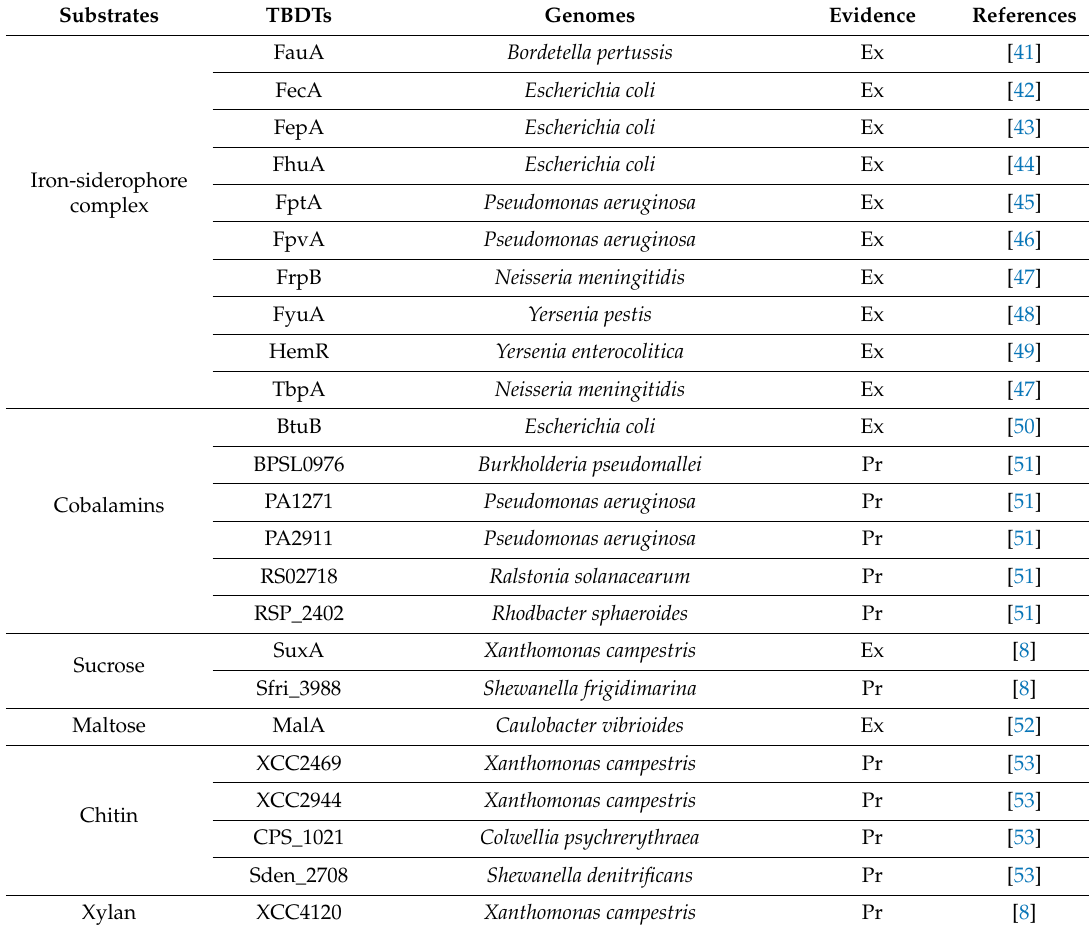
Figure 5. Gene-context analysis of two Sf TBDT sequences that clustered with xenobiotic responsive TBDTs Swit_4696 and Swit_3263 in an expression pattern-based phylogenetic tree. Table 1. Physiological role of TonB-dependent receptors